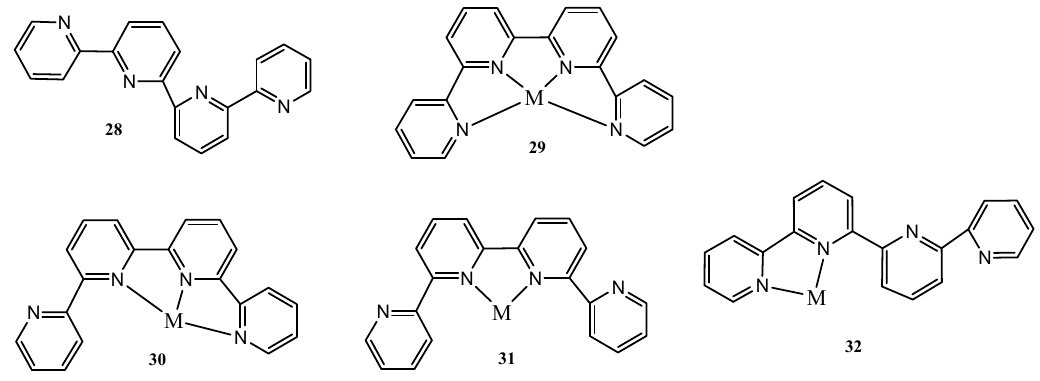
Figure 15. The different structural configurations of quaterpyridyl ligand and modes of coordination to metal ion.